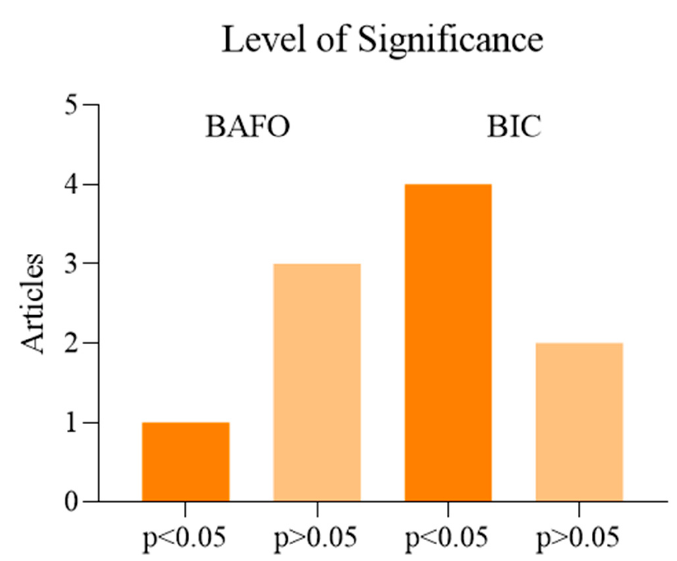
Figure 2. Comparison of the statistic value p . between the conventional technique of implant site preparation and technique with the use of drills for osseodensification. Parameters used BAFO (considered in 4 studies of 11) and BIC (considered in 6 studies of 11). For p < 0.05 we considered statistically valid the favorable results obtained by the osseodensification technique compared to the conventional technique.